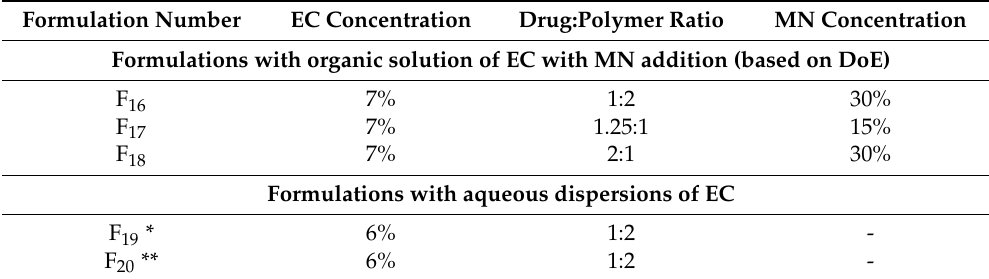
Formulation Number EC Concentration Drug:Polymer Ratio MN Concentration Formulations with organic solution of EC with MN addition (based on